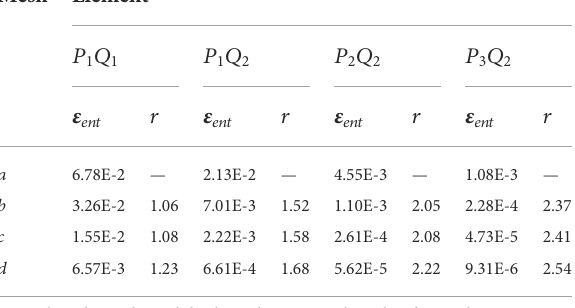
TABLE 3 L 2 errors in entropy and convergence rates for the